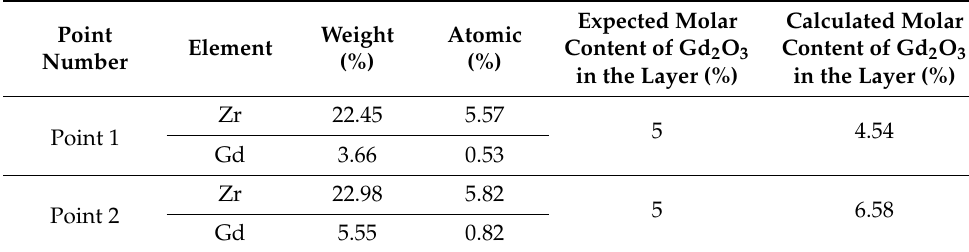
Figure 1. ZrO 2 -Gd 2 O 3 layer deposited at 550 ◦ C (surface and cross-section) ( a ) and its thickness ( b ). Molar content of Gd(tmhd) 3 in the gas reaction mixture: 10%. Synthesis time: 30 min. Table 1. Average chemical composition carried out by EDS point analysis at points 1 and 2 presented in Figure